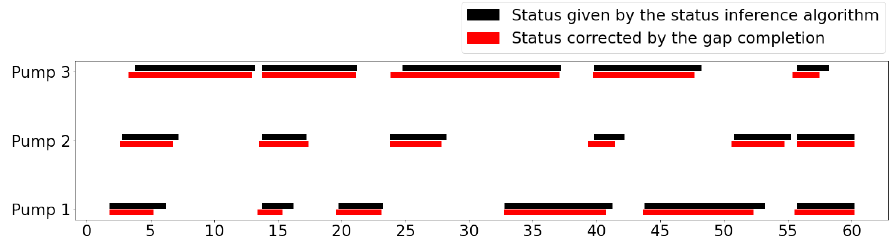
Figure 11. Timeline of the activation and deactivation of each pump for a sample of the data set, as given by the status inference algorithm from Section 2 and by its correction using the modeling established in Section 3.